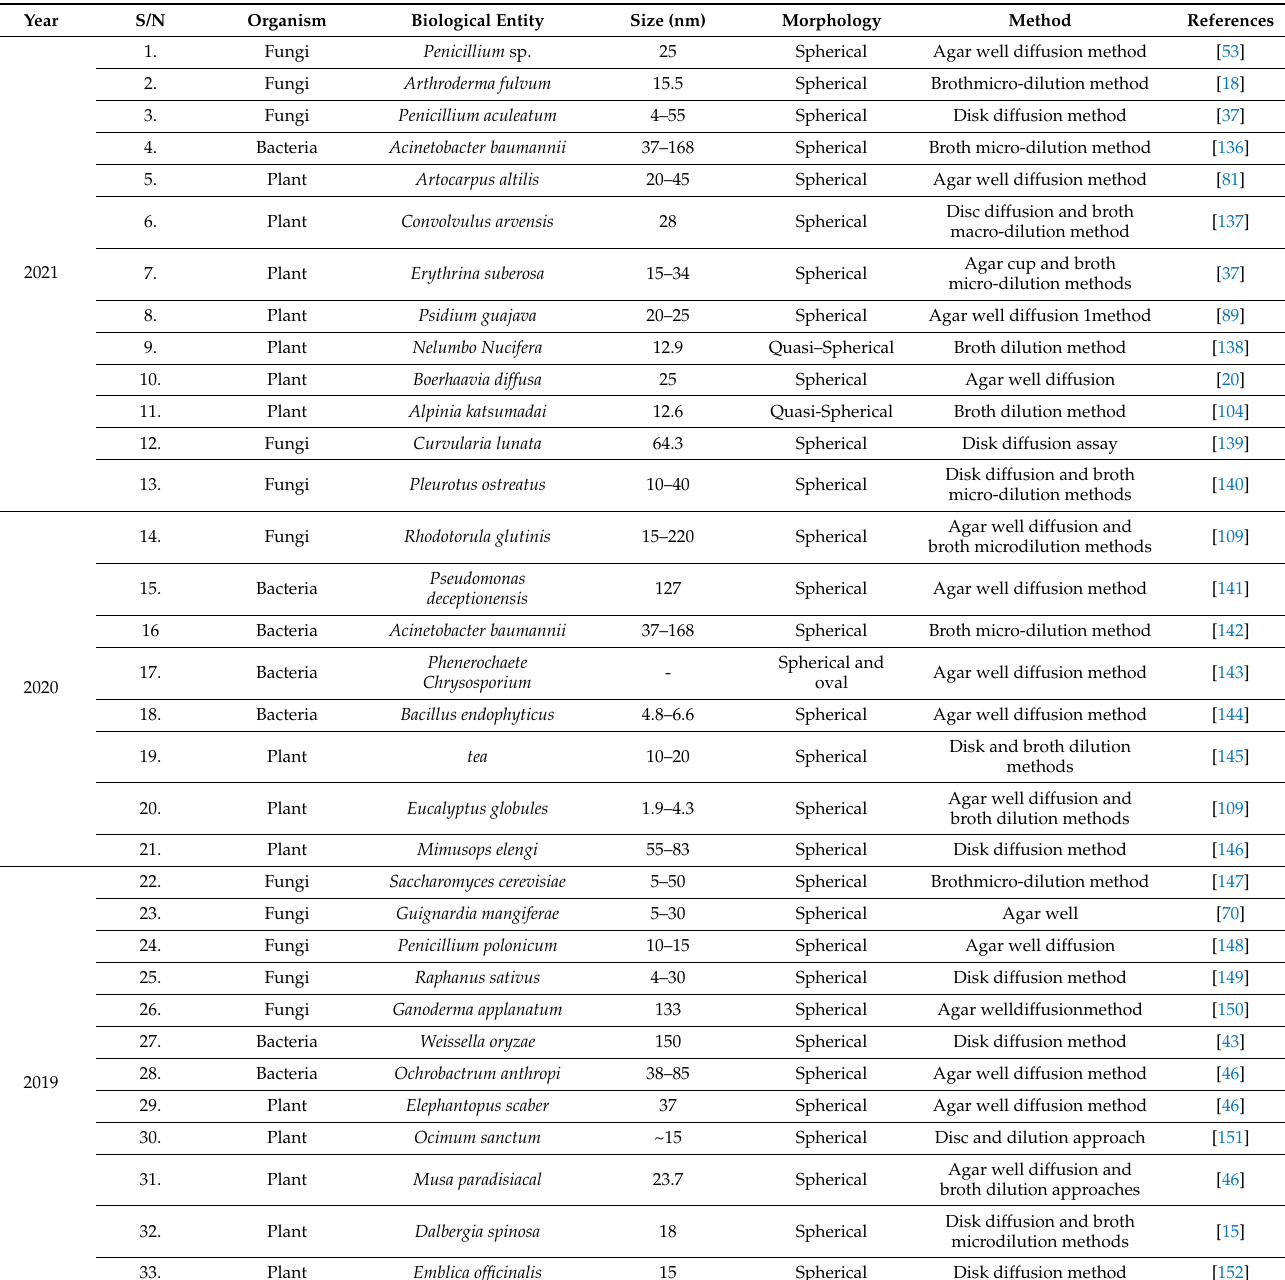
Table 4. Ag NPs prepared via bacteria, fungi, and